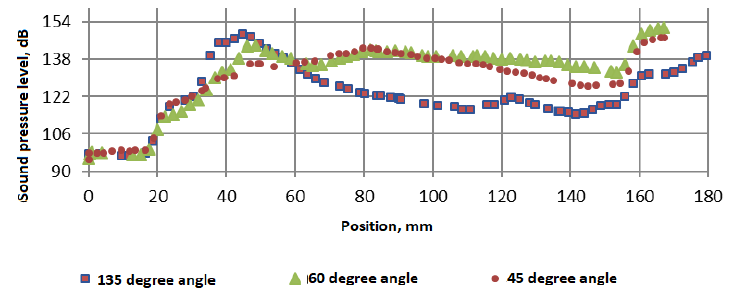
Figure 7. Comparison of sound pressure level in open cavity models.